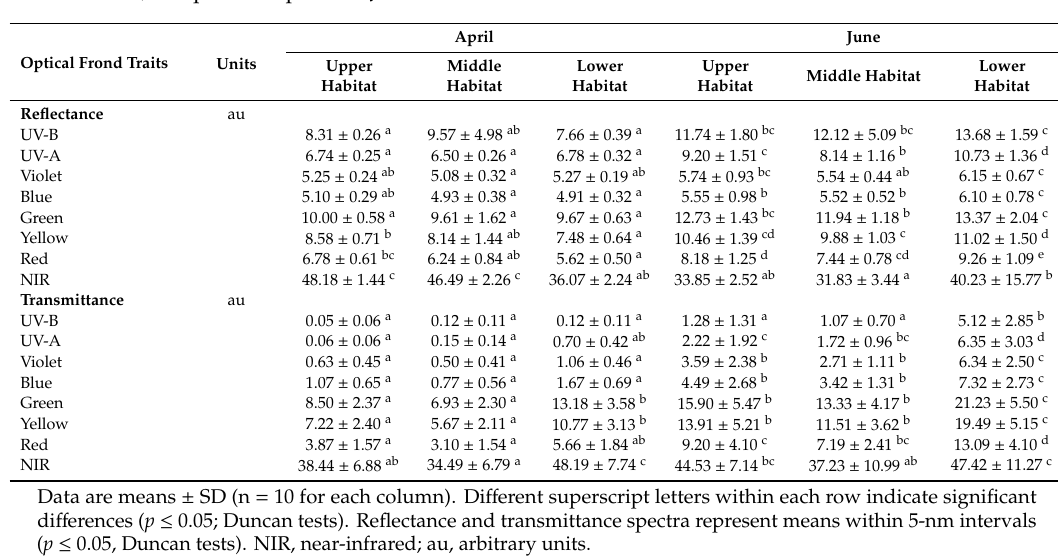
Table 2. Optical traits of the Phyllitis scolopendrium fronds from the three habitats with di ff erent light conditions, sampled in April and June.